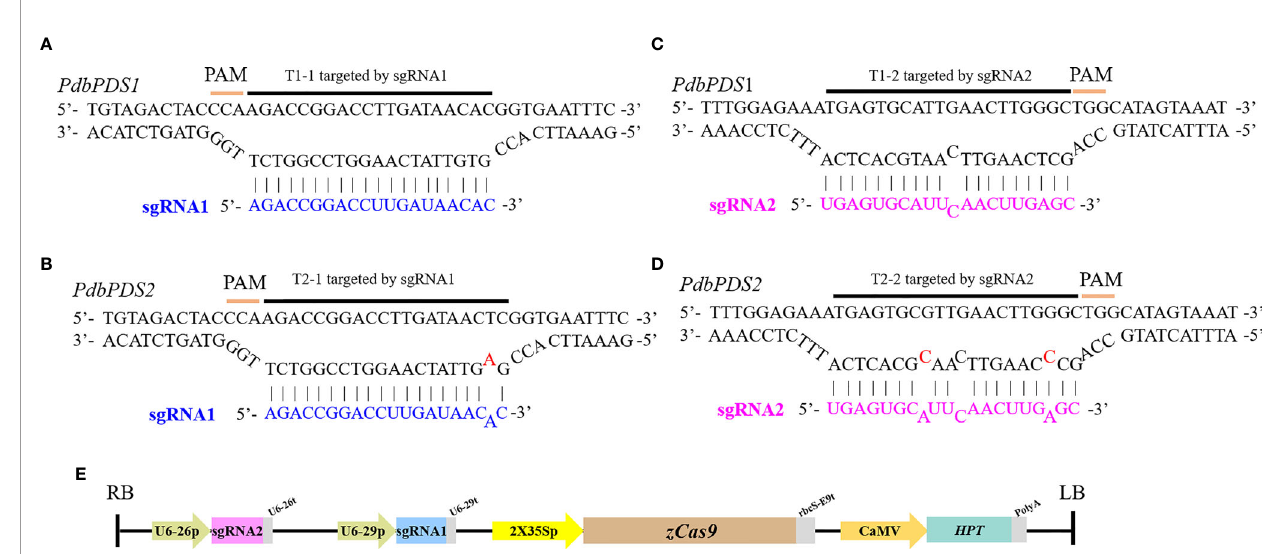
FIGURE 2 | Schematic diagram of the complementarity between the sgRNAs and target sites, as well as the vector construction. (A) Perfect complementarity between sgRNA1 and T1-1. (B) Incomplete base-pairing between sgRNA1 and T2-1. (C) Incomplete base-pairing between sgRNA2 and T1-2. (D) Three mismatches in the putative off-target site T2-2. (E) T-DNA region of the constructed gene editing vector. The abbreviations are referred to Xing et al. (2014). U6-26p and U6-29p, two Arabidopsis U6 gene promoters; U6-26t and U6-29t, two U6-26 terminators with downstream sequence; 2x35Sp, 2x35S promoter; zCas9 , Zea mays codon-optimized Cas9; rbcS-E9t, rbcS E9 terminator; CaMV, CaMV 35S promoter; Hpt , hygromycin phosphotransferase; PolyA, CaMV polyA signal. The sequence identity between 2x35Sp and CaMV is